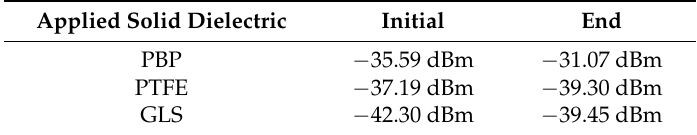
Table 2. Total energy of the UHF spectrum emitted by PD and detected by the UHF